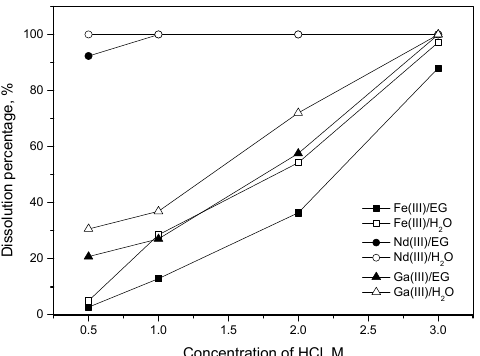
Figure 1. Effect of HCl concentration in either EG or H 2 O on the leaching of the oxide mixtures. Operation conditions: pulp density = 50 g/L, T = 80 °C, time = 90 min, stirring speed = 400 rpm.